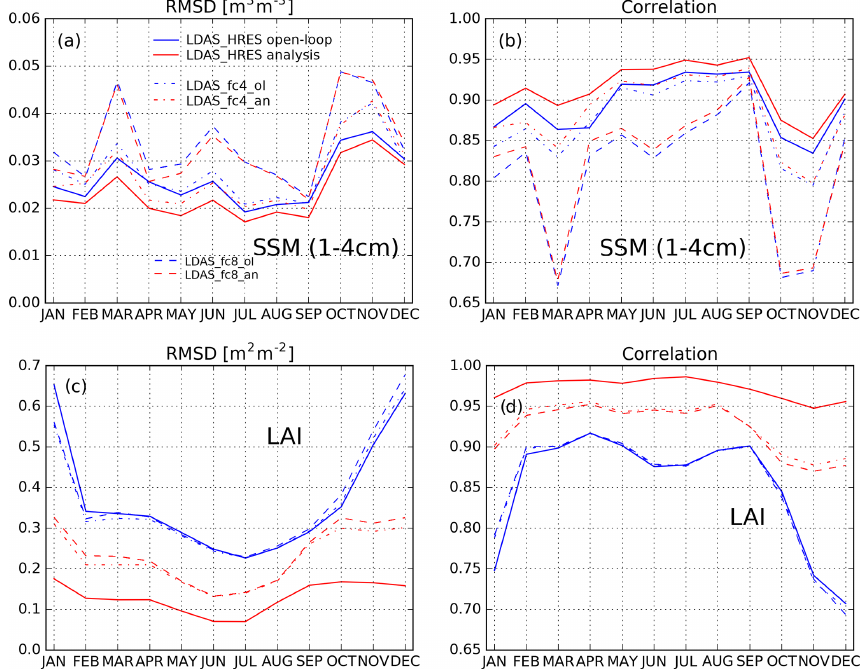
Figure 13. Same as Fig. 12 for the Murray–Darling River (MUDA) area in south-eastern